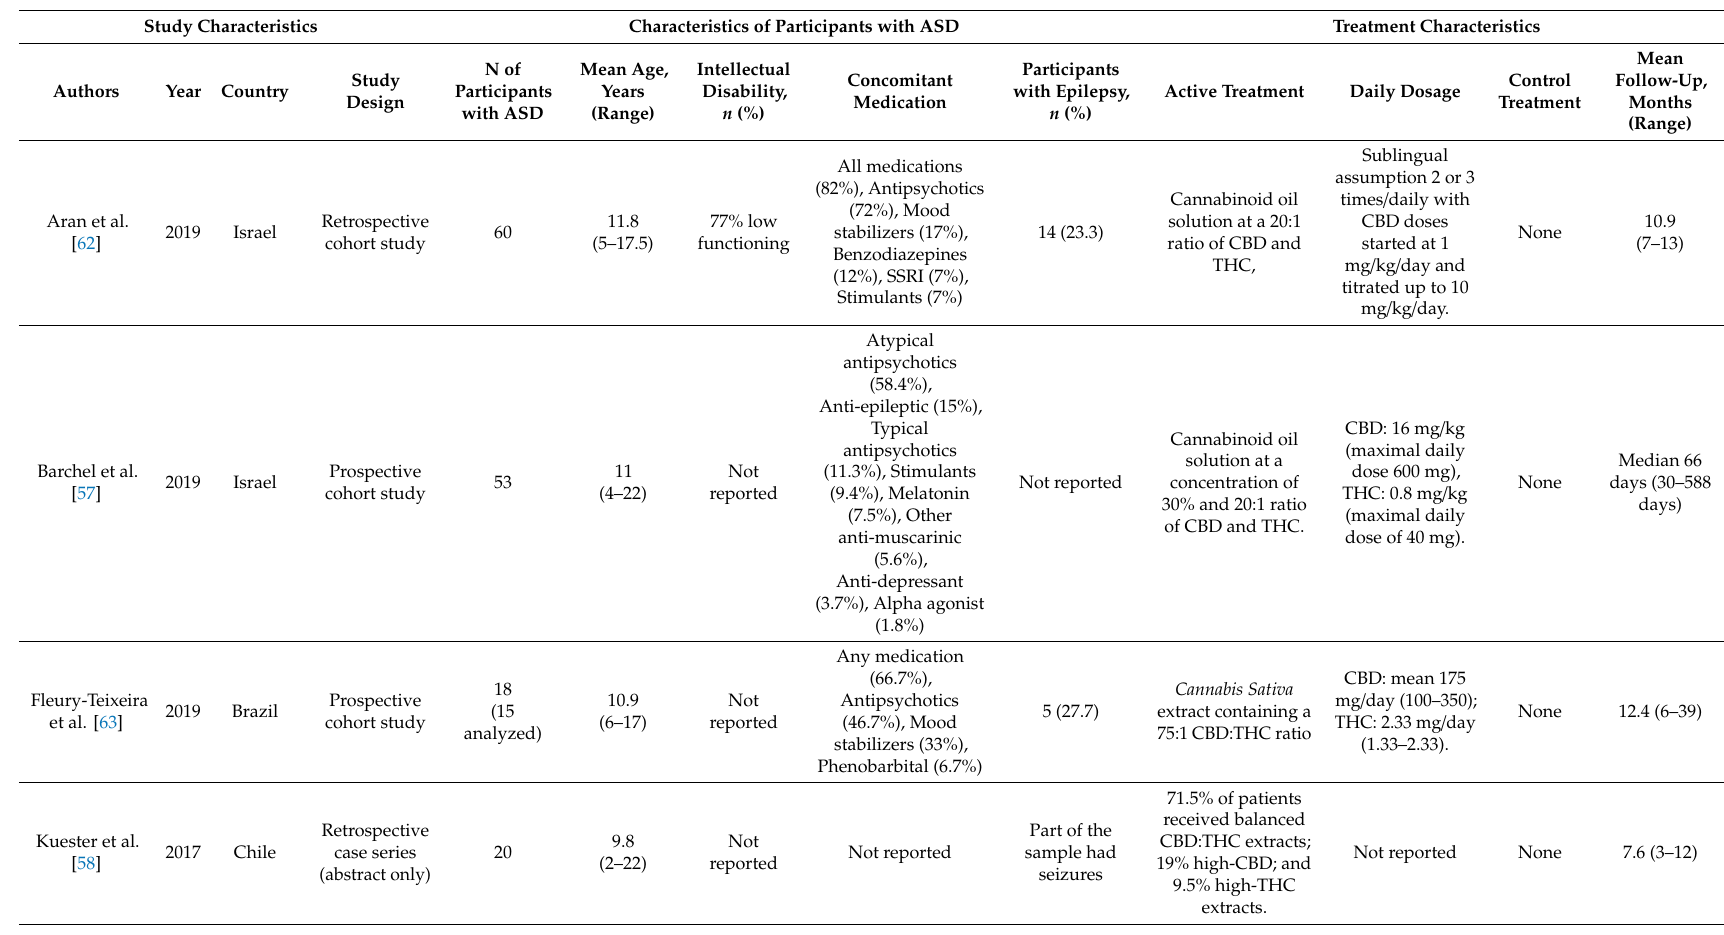
Table 1. Characteristics of the included